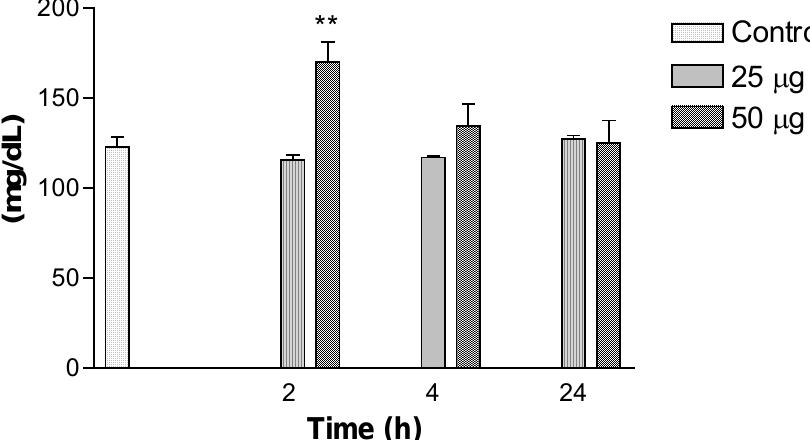
Figure 5. Variations in glucose levels in mice intraperitoneally injected with 25 or 50 μ g of Bothrops jararacussu venom diluted with 0.1ml PBS. Each bar represents the mean and vertical lines, the standard error of mean (S.E.M.) of results obtained from 6